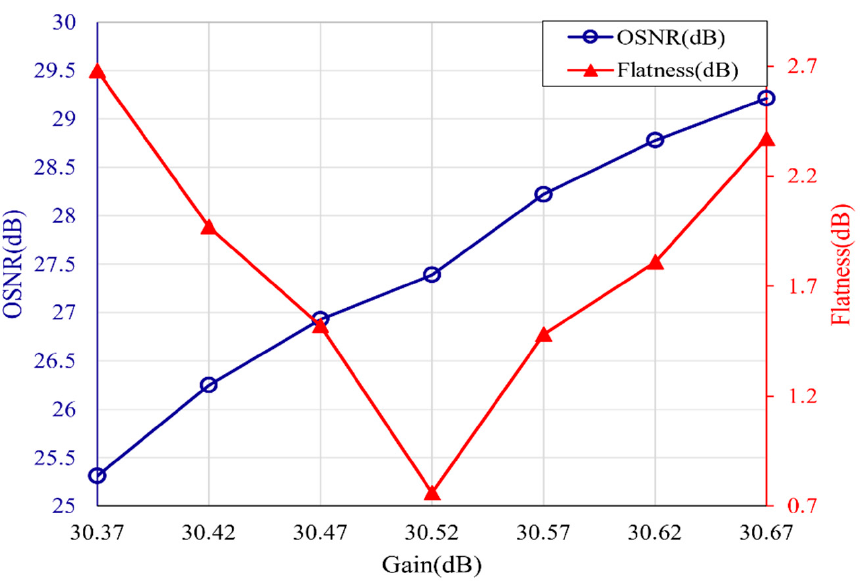
Figure 5. The effect of amplifier gains on OSNR and flatness of optical frequency